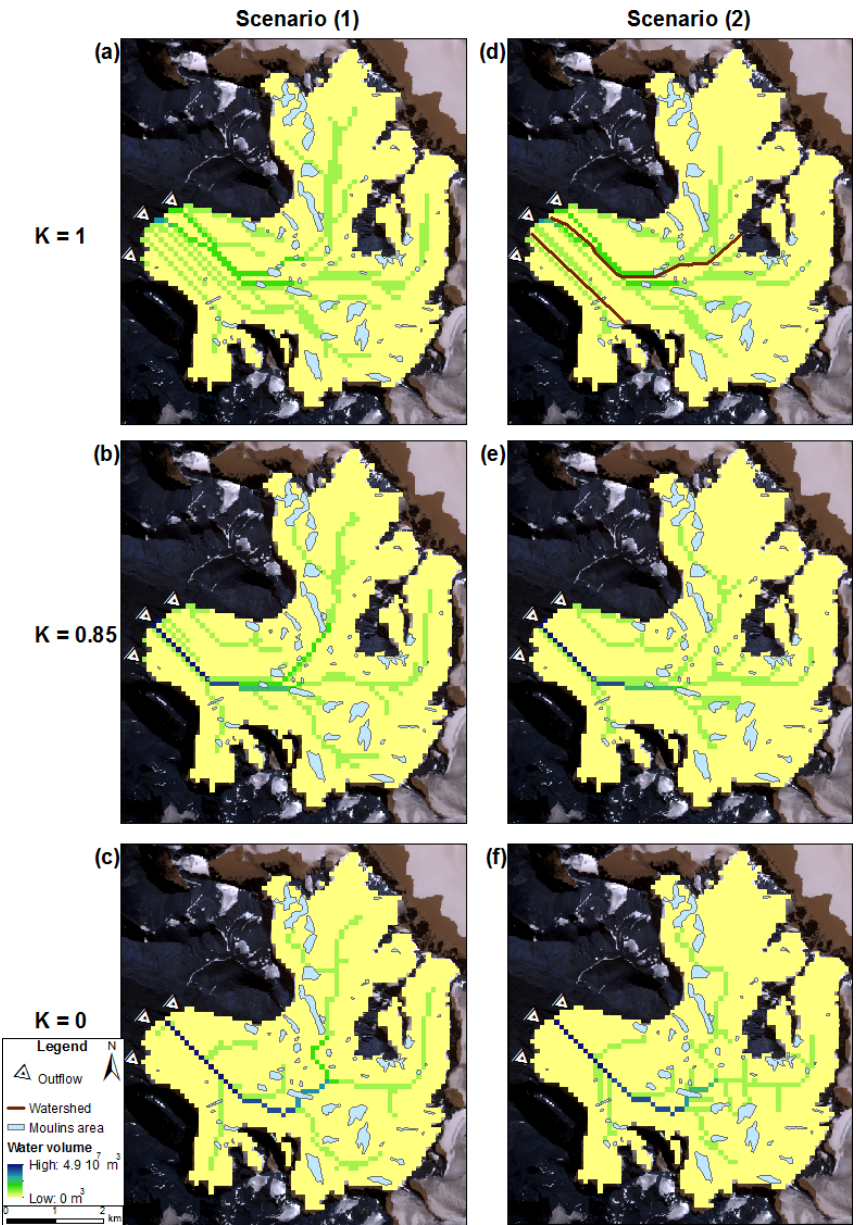
Figure 7. Map of the theoretical pattern of subglacial channels in Werenskioldbreen modeled with scenarios (1) – K = 1 (a) , K = 0 . 85 (b) , K = 0 (c) – and (2) – K = 1 (d) , K = 0 . 85 (e) , K = 0 (f) . The map background is a WorldView-2 VHRS image acquired on 21 August